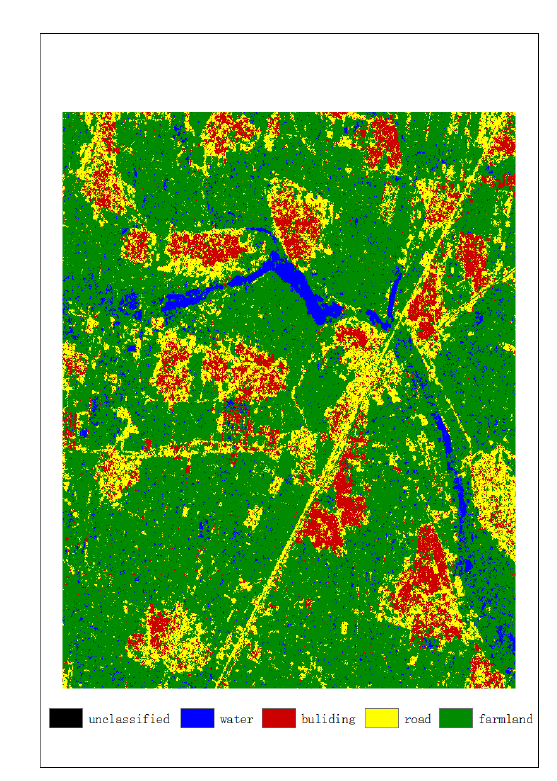
Figure 3. Classification result: (a) proposed method, (b) supervised Wishart